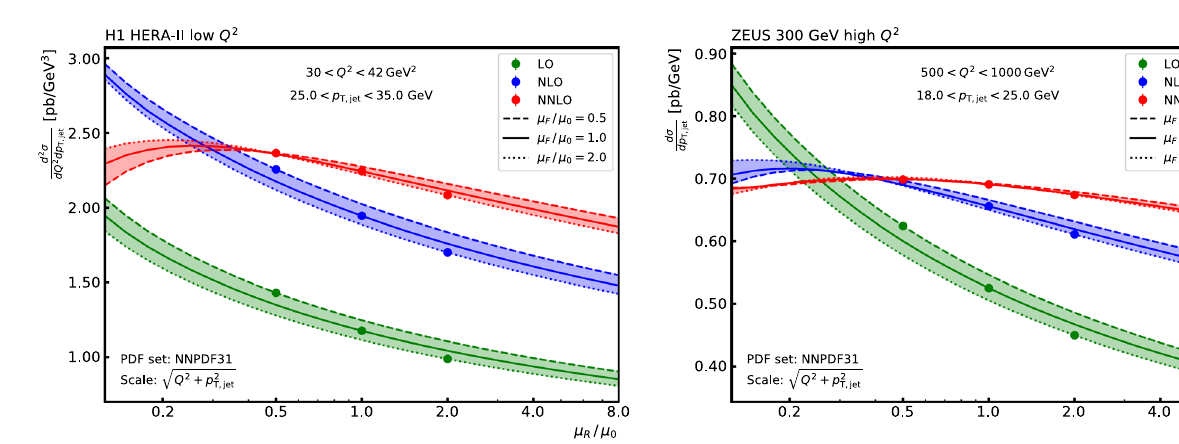
Fig. 2 Validation of the grid accuracy in di-jet production at low- Q 2 (22 < Q 2 < 30GeV 2 , top row) and high- Q 2 (150 < Q 2 < 200GeV 2 , bottom row). The shaded area indicates an agreement of 0.1%